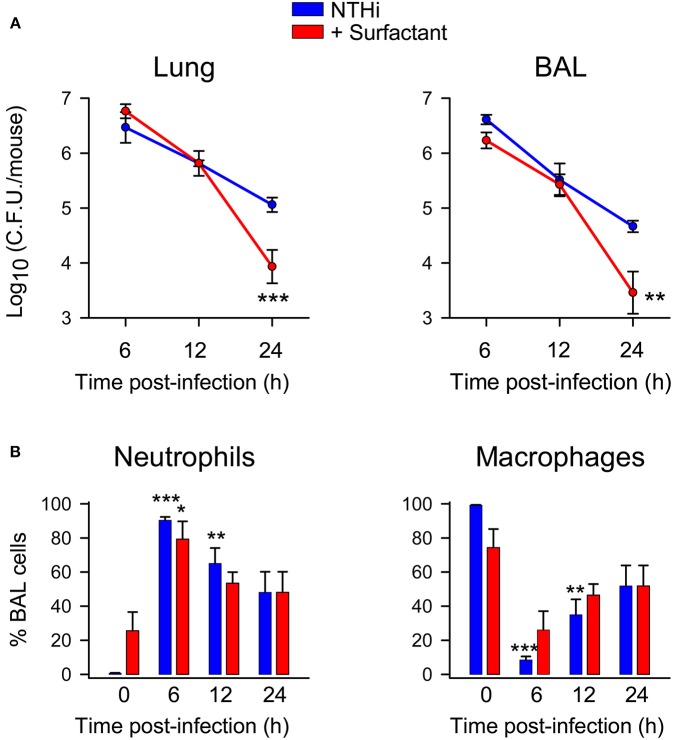
Surfactant treatment accelerated bacterial clearance in lung tissue and BAL of NTHi infected mice. Mice were intratracheally infected with otitis NTHi strain (4 × 107 C.F.U./mouse), and the hydrophobic fraction of native pulmonary surfactant (25 mg PL/kg body weigh) was simultaneously instilled into the lungs (or the same volume of PBS in the untreated infected group). Mice were euthanized at 6, 12, or 24 h postinfection. Lungs were harvested, weighed, and homogenized (left lung) or used for BAL extraction (right lung) (n = 5 mice each infected group; n = 3 mice each uninfected group). (A) The numbers of viable bacteria in lung homogenates and BAL were assessed by colony counting and expressed as log10 (C.F.U./mouse). Results are mean ± SEM. ANOVA followed by Bonferroni multiple-comparison test was used. **p < 0.01, and ***p < 0.001 when compared with untreated infected groups. (B) Percentage of alveolar macrophage and neutrophil counts in BAL. Results are mean ± SEM. ANOVA followed by the Bonferroni multiple-comparison test was used. *p < 0.05, **p < 0.01, and ***p < 0.001 when compared with the corresponding uninfected group.